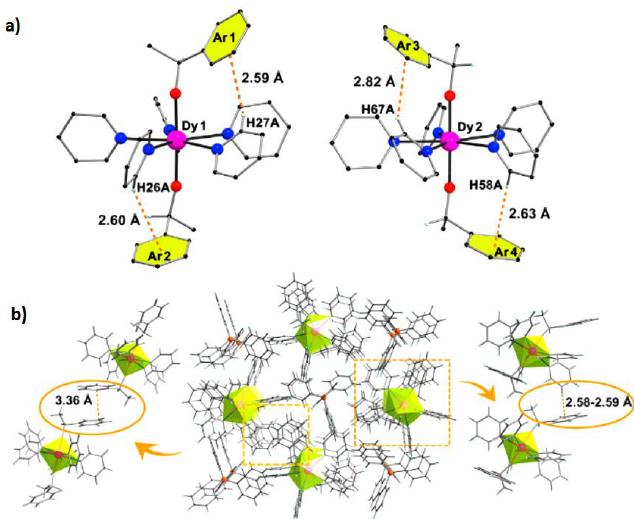
Figure 7. ( a ) Crystal structure of 3 (left) and 4 (right) and intramolecular interactions. ( b ) Inter- molecular π . . . π (left) and C-H . . . π (right) interactions between the phenyl groups of neighboring cations. Dy, magenta; C, gray; N, blue; O, red. All hydrogen atoms are omitted for clarity (adapted with permission from